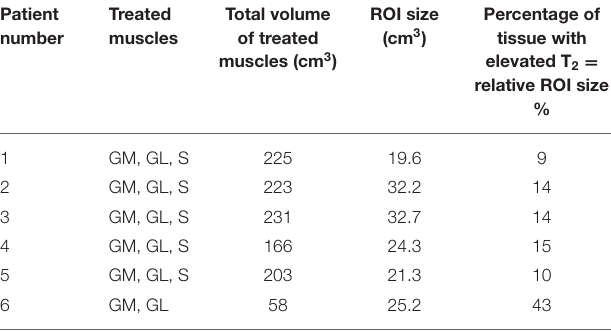
TABLE 2 | Volume of treated muscles and percentage of tissue with elevated T 2 , i.e., relative ROI size at 6 weeks post-BTX. Patient